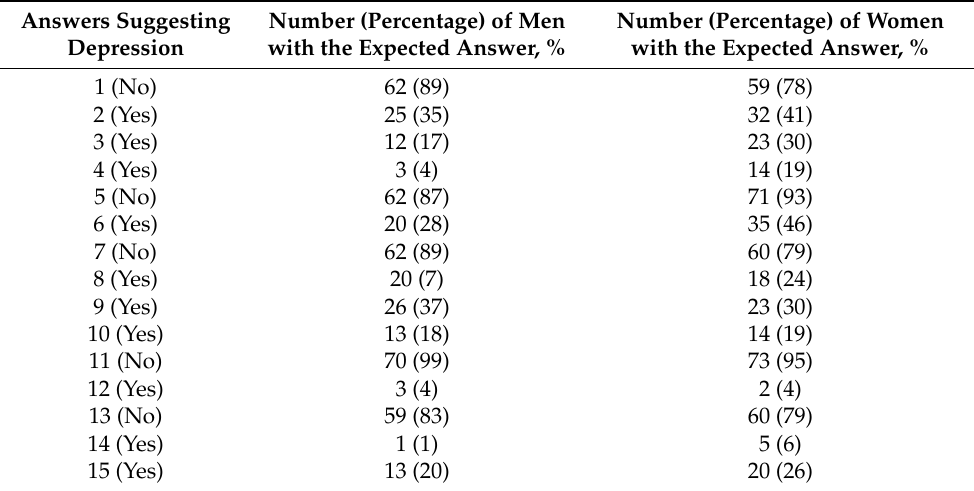
Table 2. Numbers and percentages of men and women whose GDS score was indicative of depression. Answers Suggesting